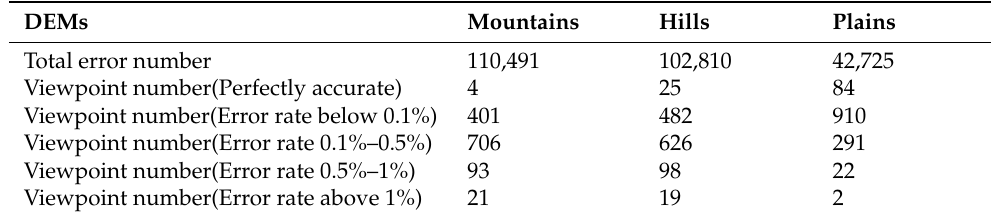
Table 3. Total error number and viewpoint number with different error rate with PDERL (with problem 1 solved) (Total viewpoint number: